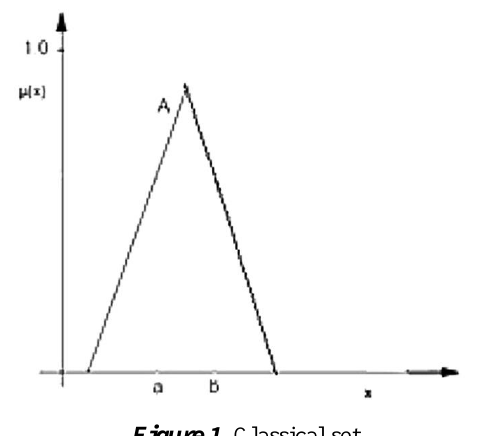
Figure 1. Classical set.